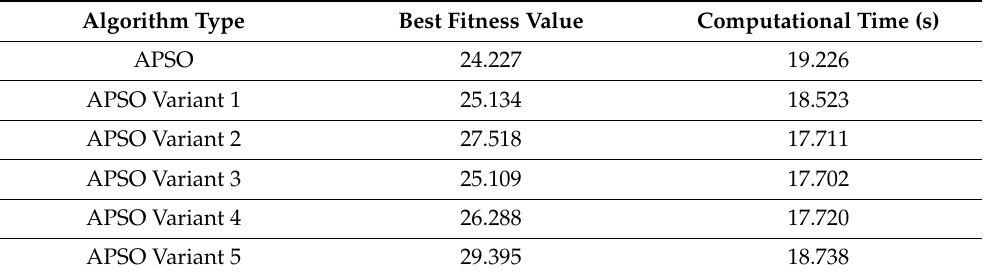
Table 7. Summarized results of APSO and its variants for 100 PHEVS.